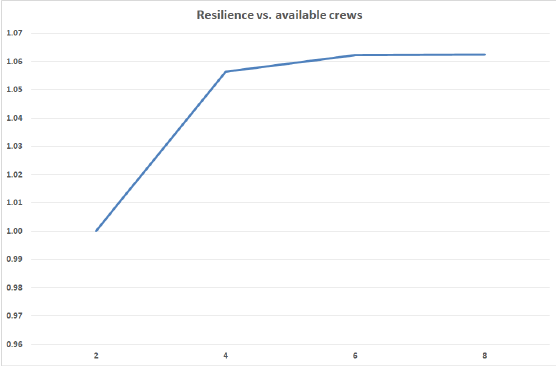
Figure 12. Resilience as a function of the available intervention crews.